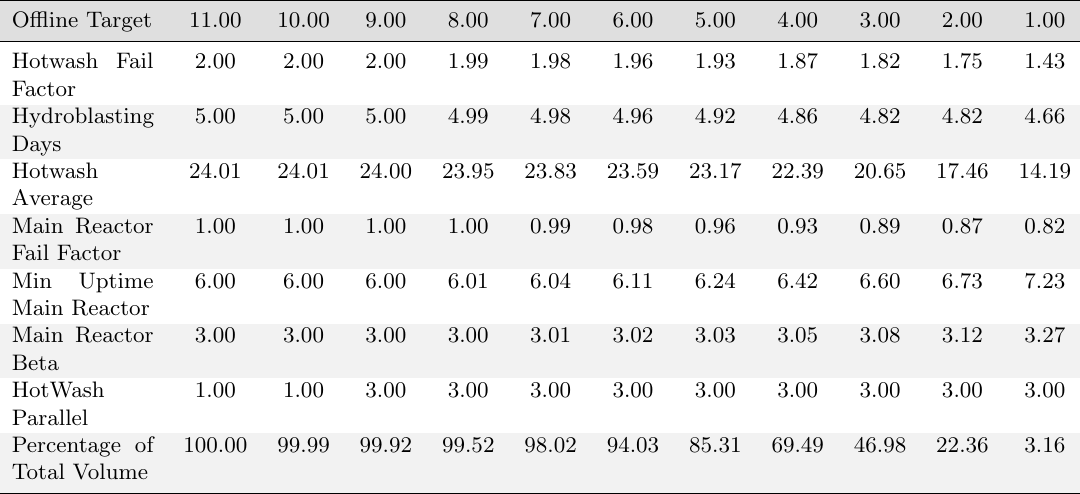
Table 6: Mean values of factors for different percentage time offline